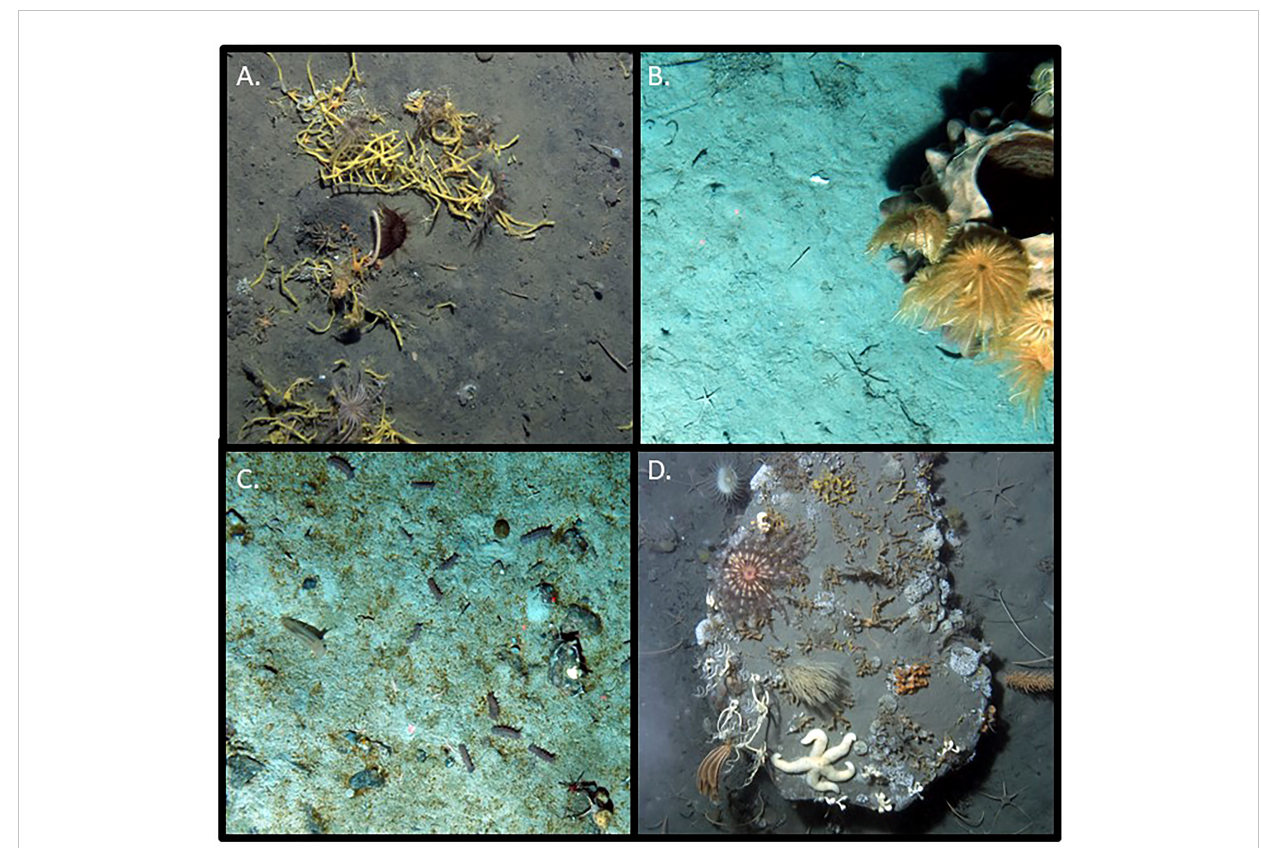
FIGURE 5 Example of sampling sites (A) Montravel Rock with yellow rope sponge, (B) Mid Ross Sea site, (C) Eastern Amundsen with abundant holothuroids, and (D) the drop stone found at the Seymour Island